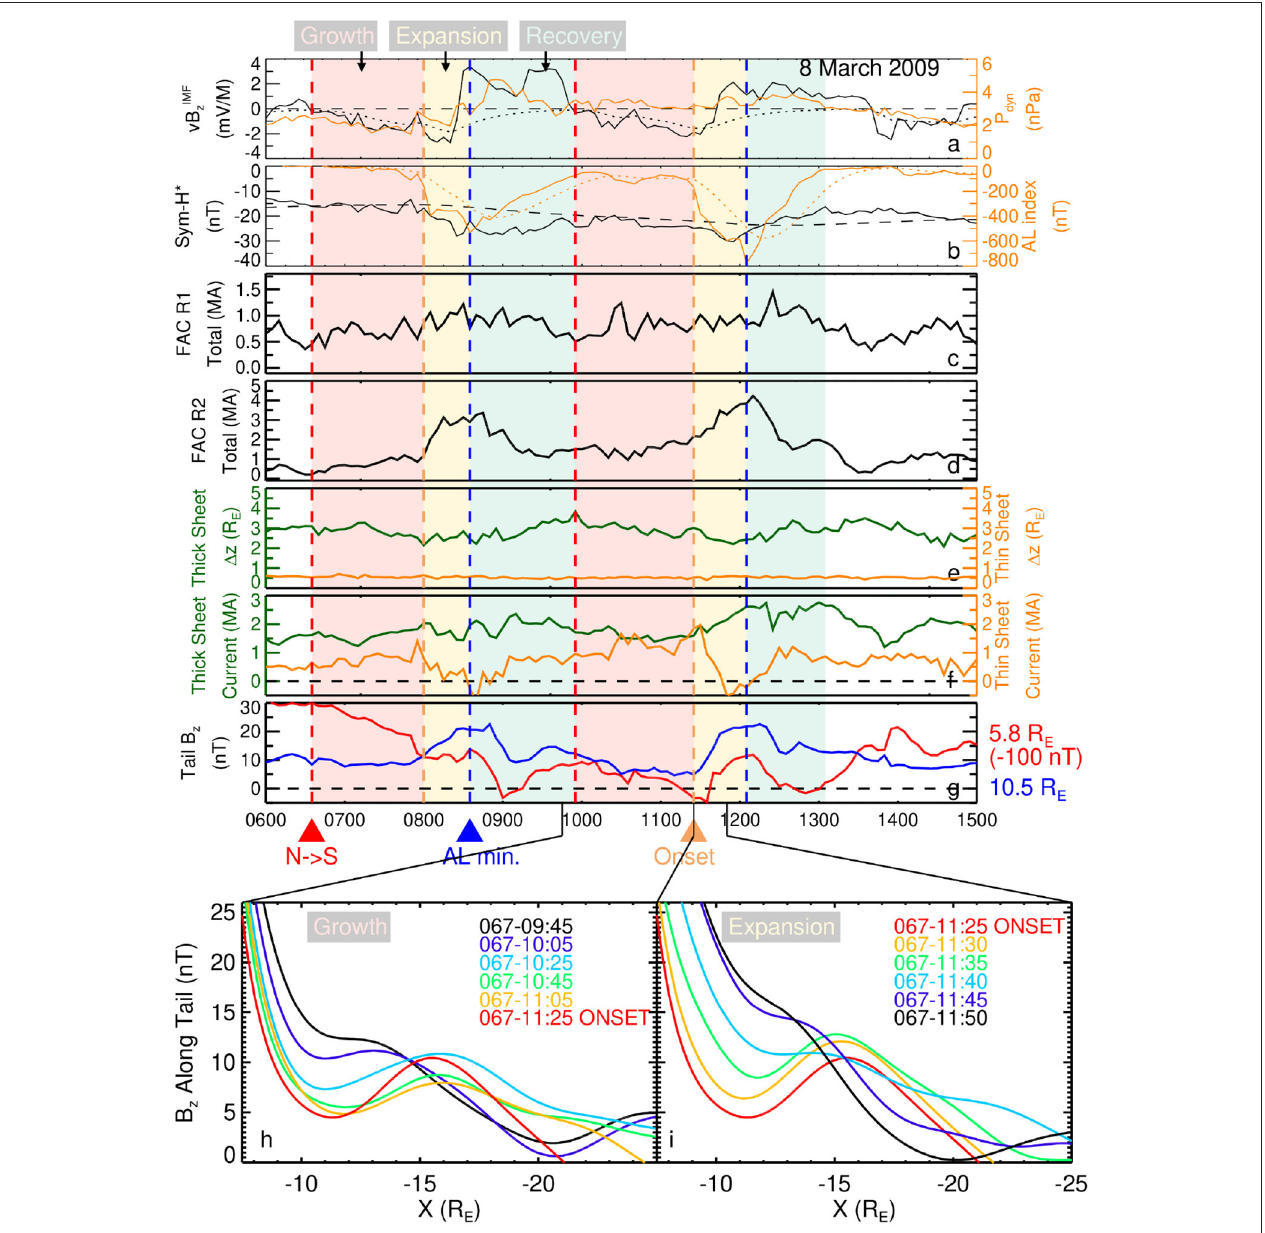
FIGURE 8 | The Merged Model quantitative analysis. (a,b) Geomagnetic indices and solar wind parameters in a format similar to Figures 6a,b . (c,d) The root mean square of the FAC amplitude coefficients for the R1 and R2 FAC modules, respectively. (e) The values of the current sheet half thicknesses for the thick sheet (green line) and TCS (orange line), i.e., D and D TCS from Equation (2). (f) A measurement of the amount of current contained in the dayside SRC (green line) and nightside TCS (orange line). The SRC current (green line) is computed by integrating the dayside westward current density of the thick current sheet module flowing within x geosynchronous orbit 1.0 R E 6.616 R E and z 5 R E . The TCS current (orange line) is computed by integrating the nightside westward current density of the ≤ ≤ = ± r TCS module flowing within the rectangle 16 R E 6 R E and z 1.0 R E . (g) The z -component of the total magnetic field B z sampled at x − ≤ ≤ − = ± and x 10.5 R E (blue line). (h,i) The z -component of the total magnetic field B z along the nightside x -axis at different times during the growth and expansion phases. = −